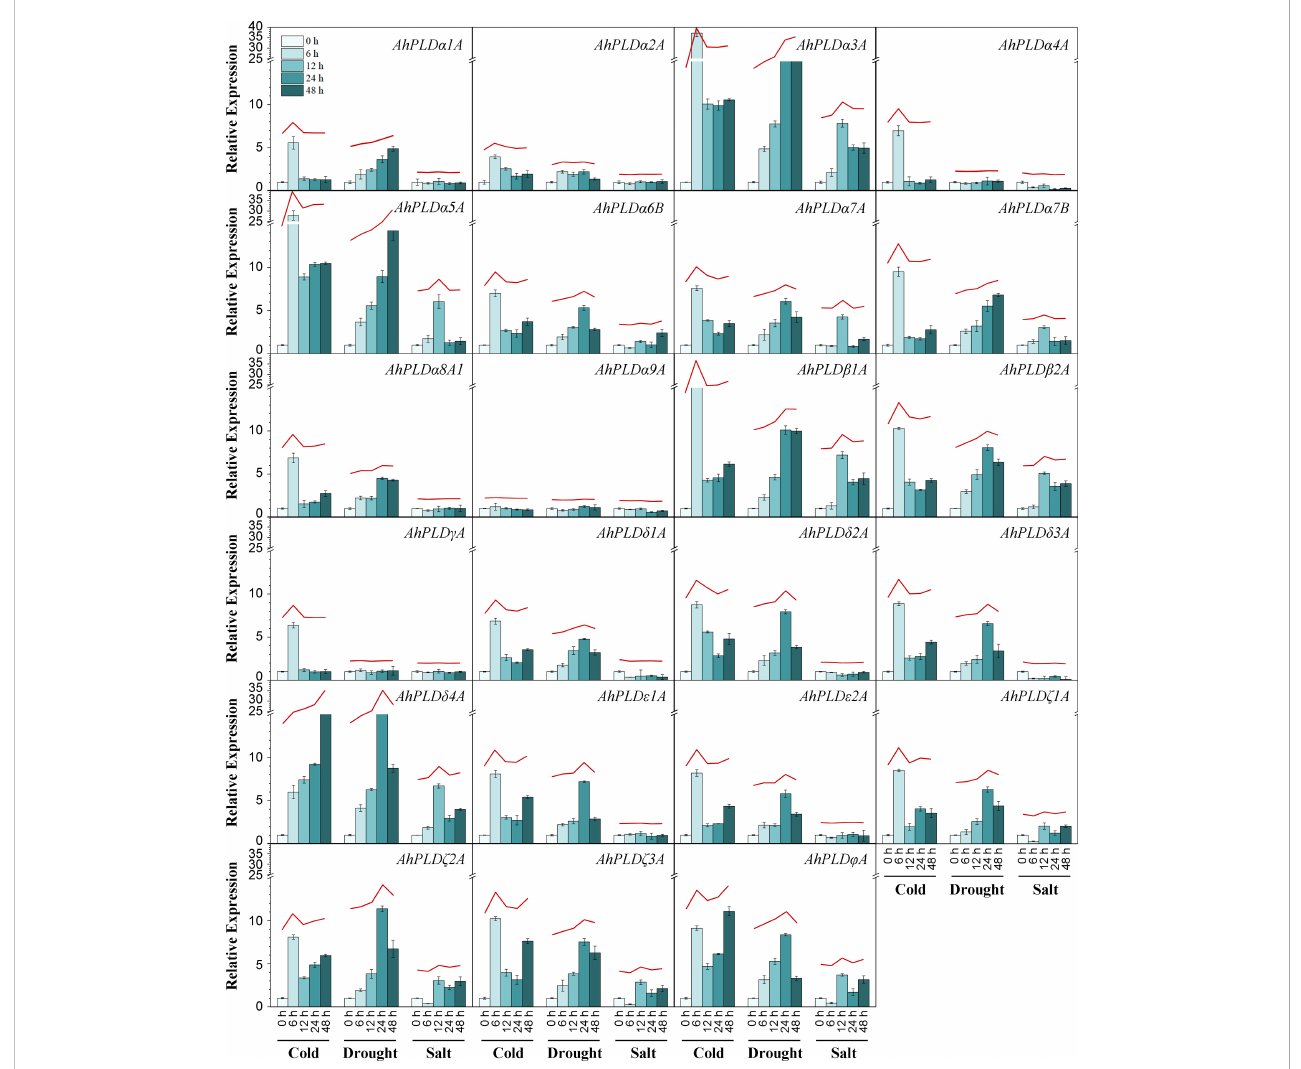
FIGURE 9 Expression pro fi les of AhPLDs under abiotic stresses. The expression levels of AhPLDs under cold, drought and salt were generated using qRT-PCR. The X axis represents different treatments. The Y axis represents relative expression levels of AhPLDs . Each bar represents average of three replicates. Standard error is indicated by error bars. The red lines above bars represent the overall trends of AhPLDs expressions under different abiotic